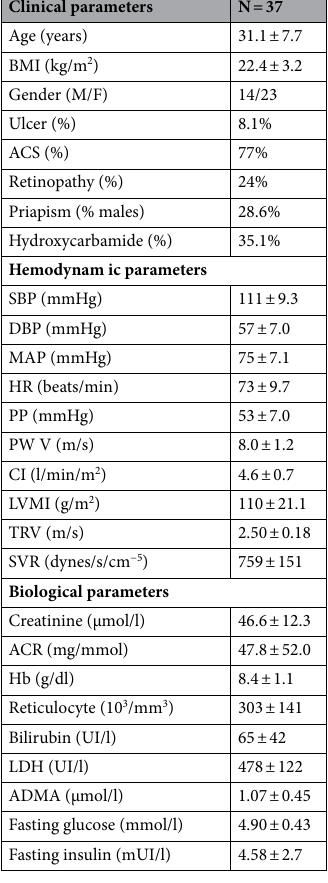
Table 1. Population characteristics. BMI: body mass index; ACS: acute chest syndrome; SBP: systolic blood pressure; DBP: diastolic blood pressure; MAP: mean arterial pressure; HR: heart rate; PP: pulse pressure; PWV: pulse wave velocity; CI: cardiac index; LVMI: left ventricular mass index; TRV: tricuspid regurgitation velocity; SVR: systemic vascular resistance; ACR: albumin creatinine ratio; Hb: haemoglobin; LDH: lactic dehydrogenase; ADMA: asymetric dimethyl